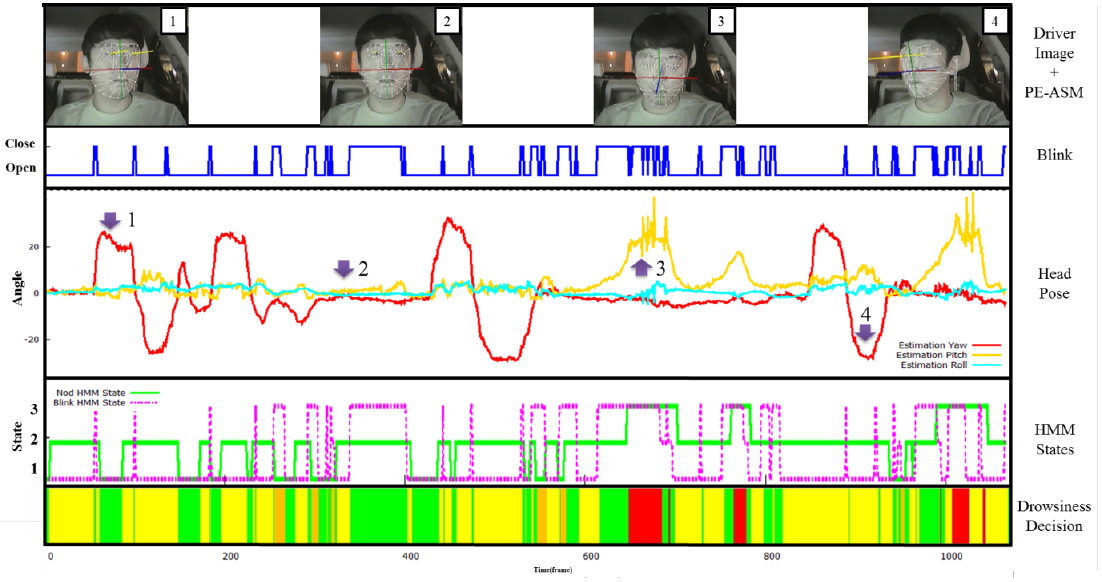
Figure 12. Detection of driver’s drowsiness using PE-ASM (Pose Extended – Active Shape Model) and HMM: PE-ASM is applied to the images of a driver ( top panel ), eye-blinking ( 2 nd panel ), head pose ( 3 rd panel ), HMM states ( 4 th panel ) and the decision of driver’s drowsiness ( bottom panel ). Note that whenever blinking and nodding HMM states are overlapped, the system detects drowsiness of the driver, indicated as red rectangles, as shown in the bottom panel.